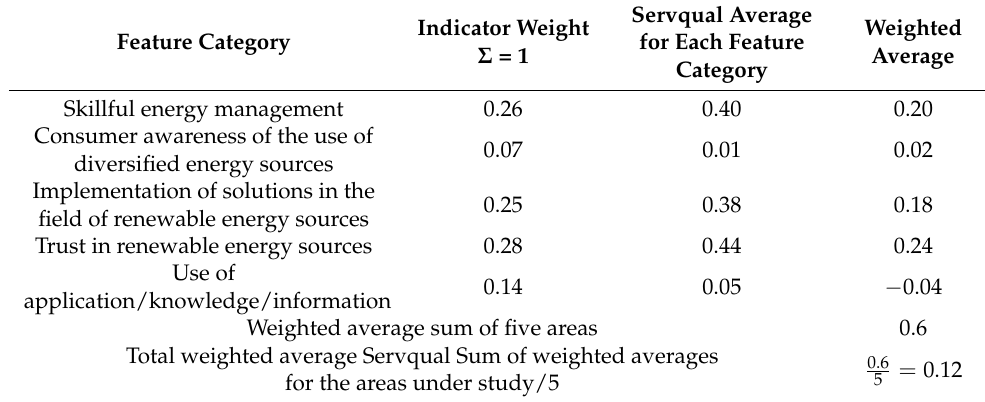
Table 5. Weighted averages for the Servqual analysis.